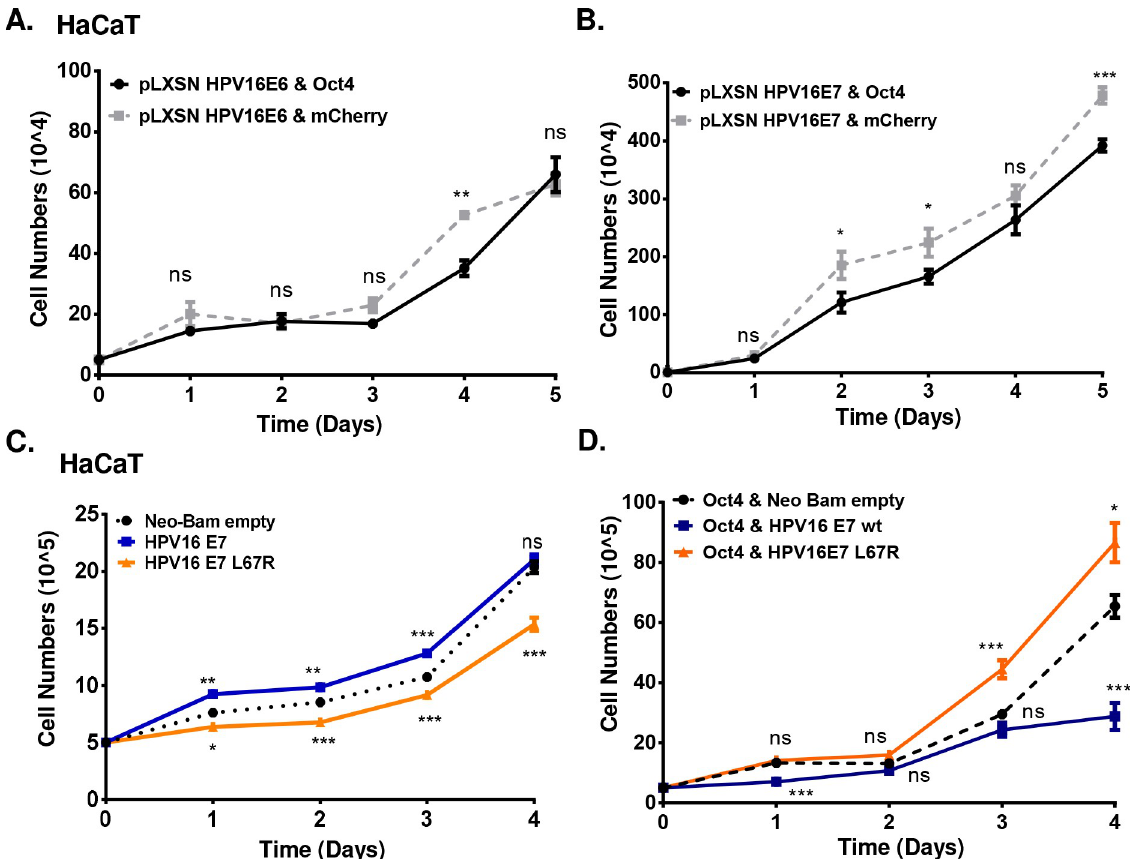
Fig 9. HaCaT Oct4-related proliferation is mediated by the Oct4-E7 interaction. HaCaT cells with stable expression of (A) pLXSN HPV16E6 & Oct4 and pLXSN HPV16E6 & mCherry (B) pLXSN HPV16E7 & Oct4 and pLXSN HPV16E7 & mCherry were used to construct a growth curve for a period of 5 days. (C) HaCaT cells were transfected with cmv-Neo Bam empty, cmv 16E7 wildtype and cmv 16E7 L67R constructs. The proliferation of those cells was presented in the form of a growth curve. (D) Stable Oct4-transduced HaCaT cells were also transfected with cmv-Neo Bam empty, cmv 16E7 wildtype and cmv 16E7 L67R constructs to examine the effect of Oct4 and E7 on the proliferation of immortalized keratinocytes. The p value shown on the graph indicates the comparison between the wildtype and mutant E7 with the empty control. The comparison of wildtype E7 with the L67R mutant indicates of p value of (Day 1 ���� p < 0.0001, day 2 �� p < 0.01, day 3 ��� p < 0.001, day 4 ���� p < 0.0001). Data were derived from three biological replicates each done in triplicate (mean ± SEM) and statistical analysis was performed with Mann-Whitney U t-test (two-sided) (ns = non-significant, � p < 0.05, �� p < 0.01, ��� p < 0.001, ���� p <